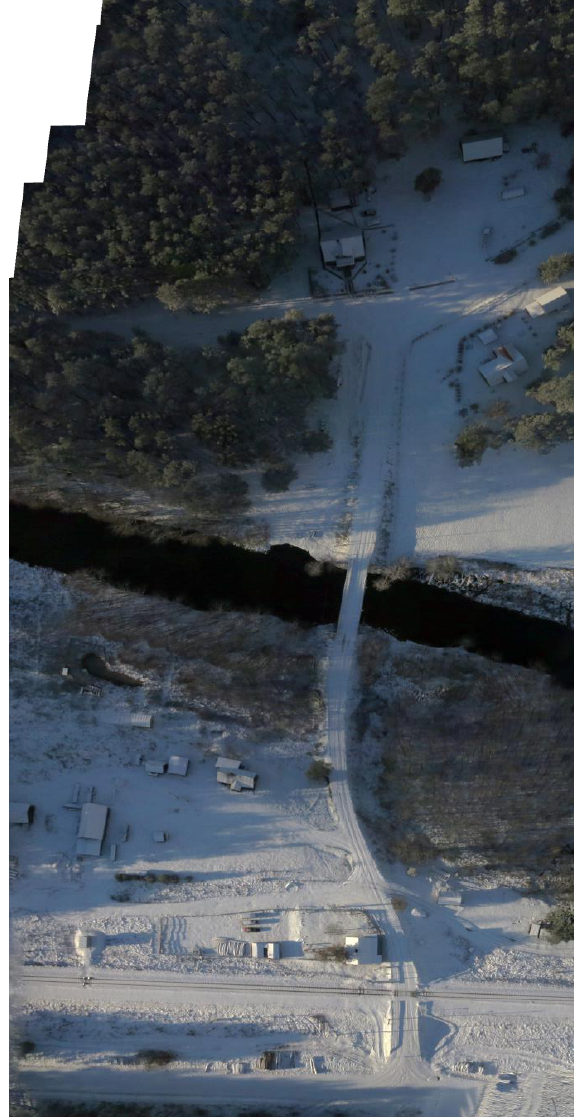
Figure 5. Ortophoto mosaic of the object